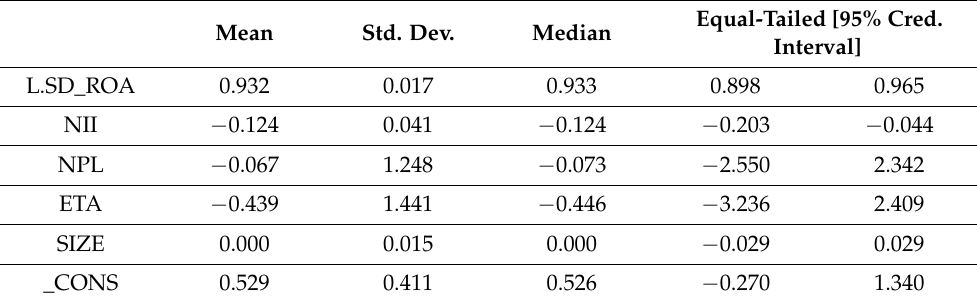
Equal-Tailed [95% Cred.